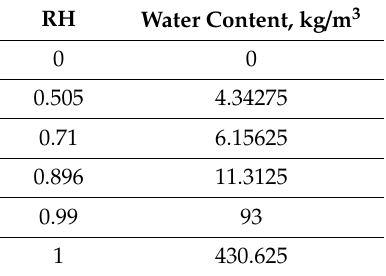
Table A27. Moisture storage function.